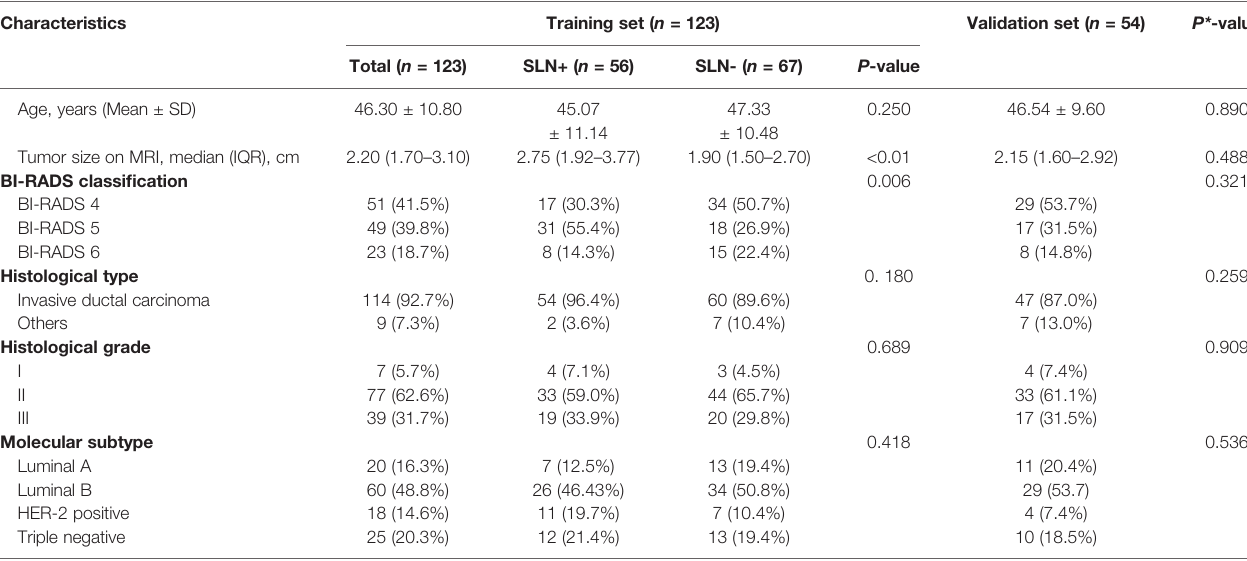
TABLE 1 | Clinical and histopathological characteristics. Characteristics